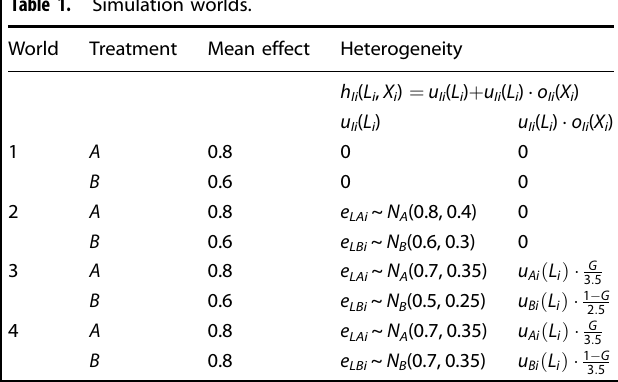
Table 1. Simulation